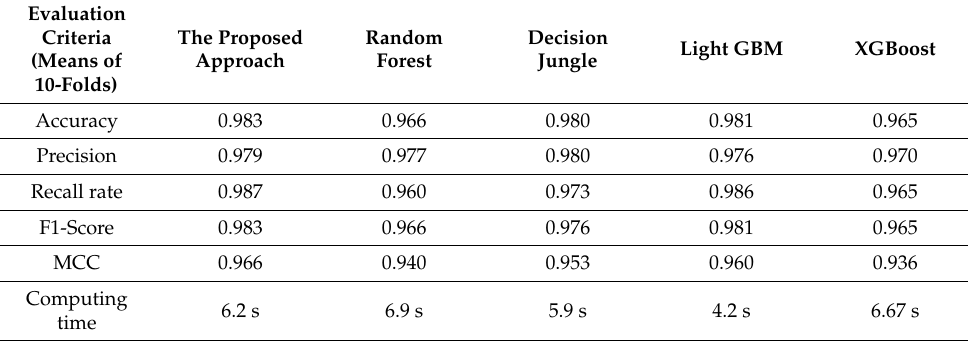
Table 4. The overall results of the ensemble learning based models.